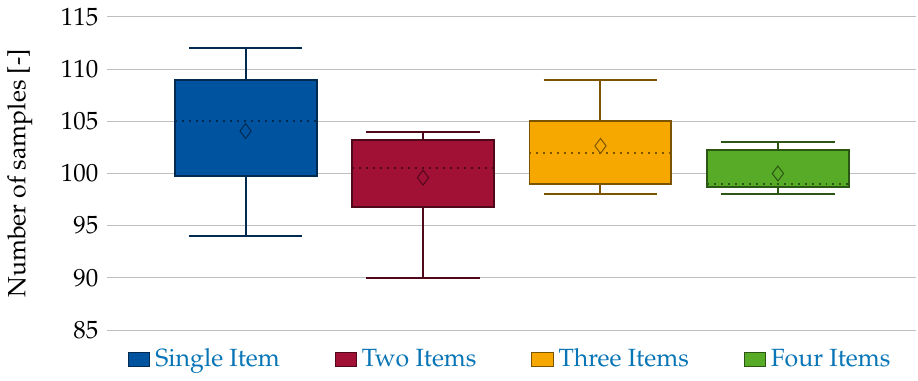
Figure 14. Number of segmented objects per two minutes and